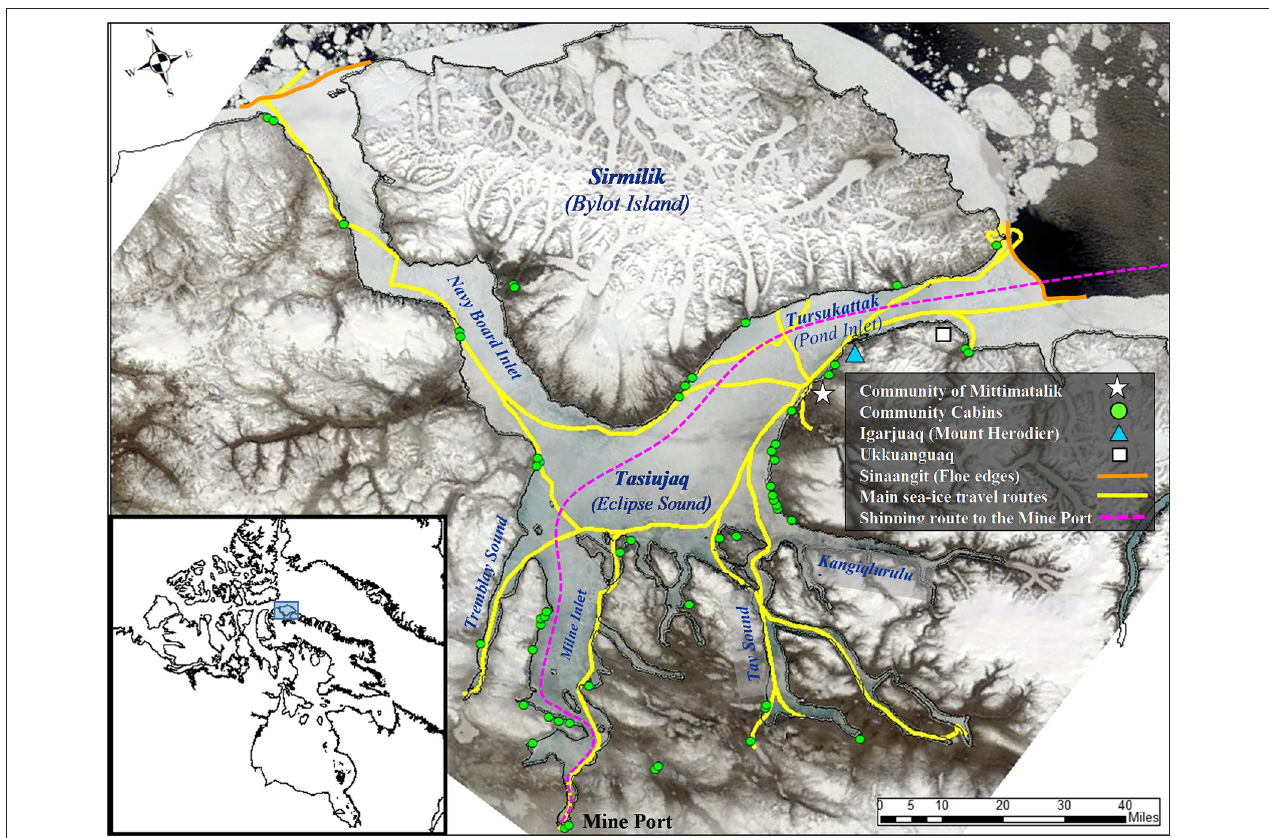
FIGURE 1 | Geographical location of the community of Mittimatalik, Nunavut, Canada. Background image MODIS True Color Composite, June 9, 2019 (NASA,